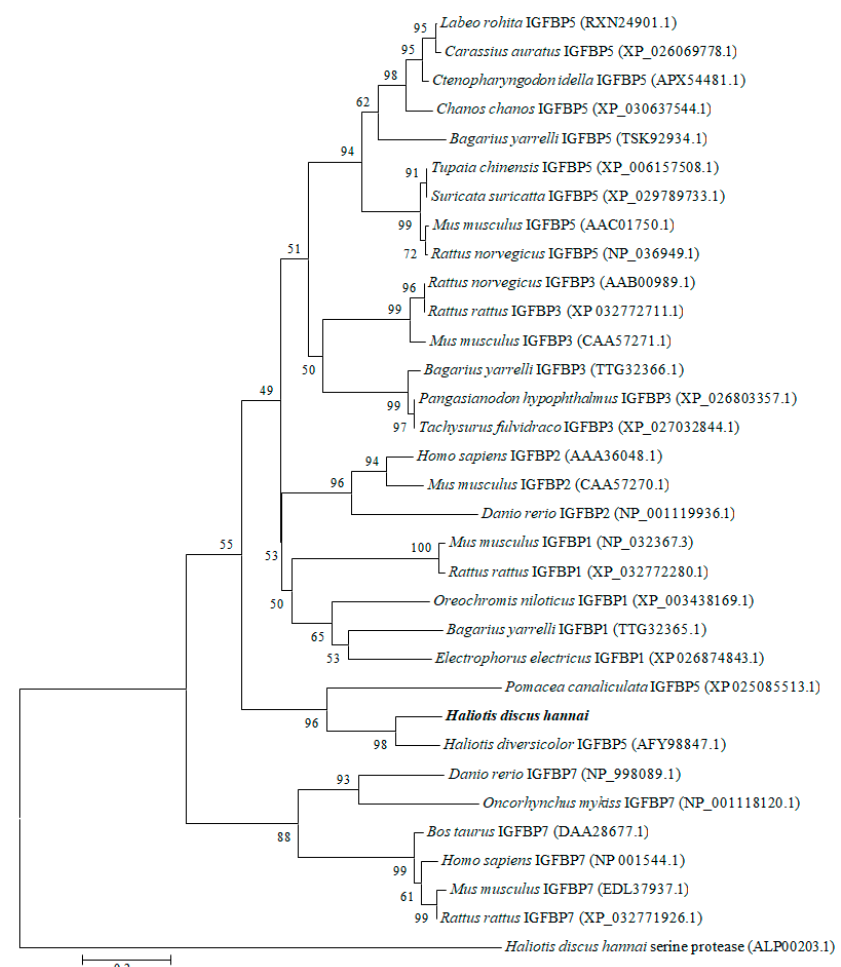
Figure 3. Phylogenetic tree was constructed based on amino acid sequences of IGFBP-5 from vertebrates and invertebrates. Phylogenetic tree analysis was performed using a neighbor-joining method with 1000 bootstrap replicates. The scale bar indicates an evolutionary distance of 0.2 amino acid divergence per site. Hdh IGFBP-5 in this study is highlighted in bold font. GenBank accession numbers are shown in parentheses.